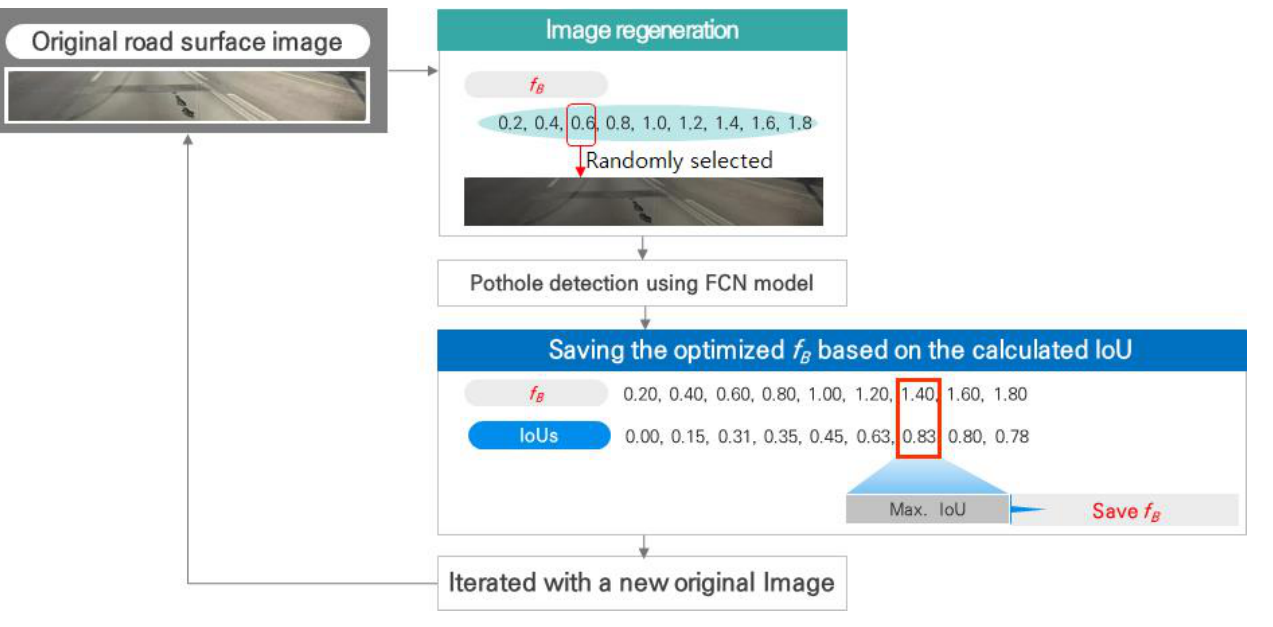
Figure 8. Dataset creation process for application in the image preprocessing model.